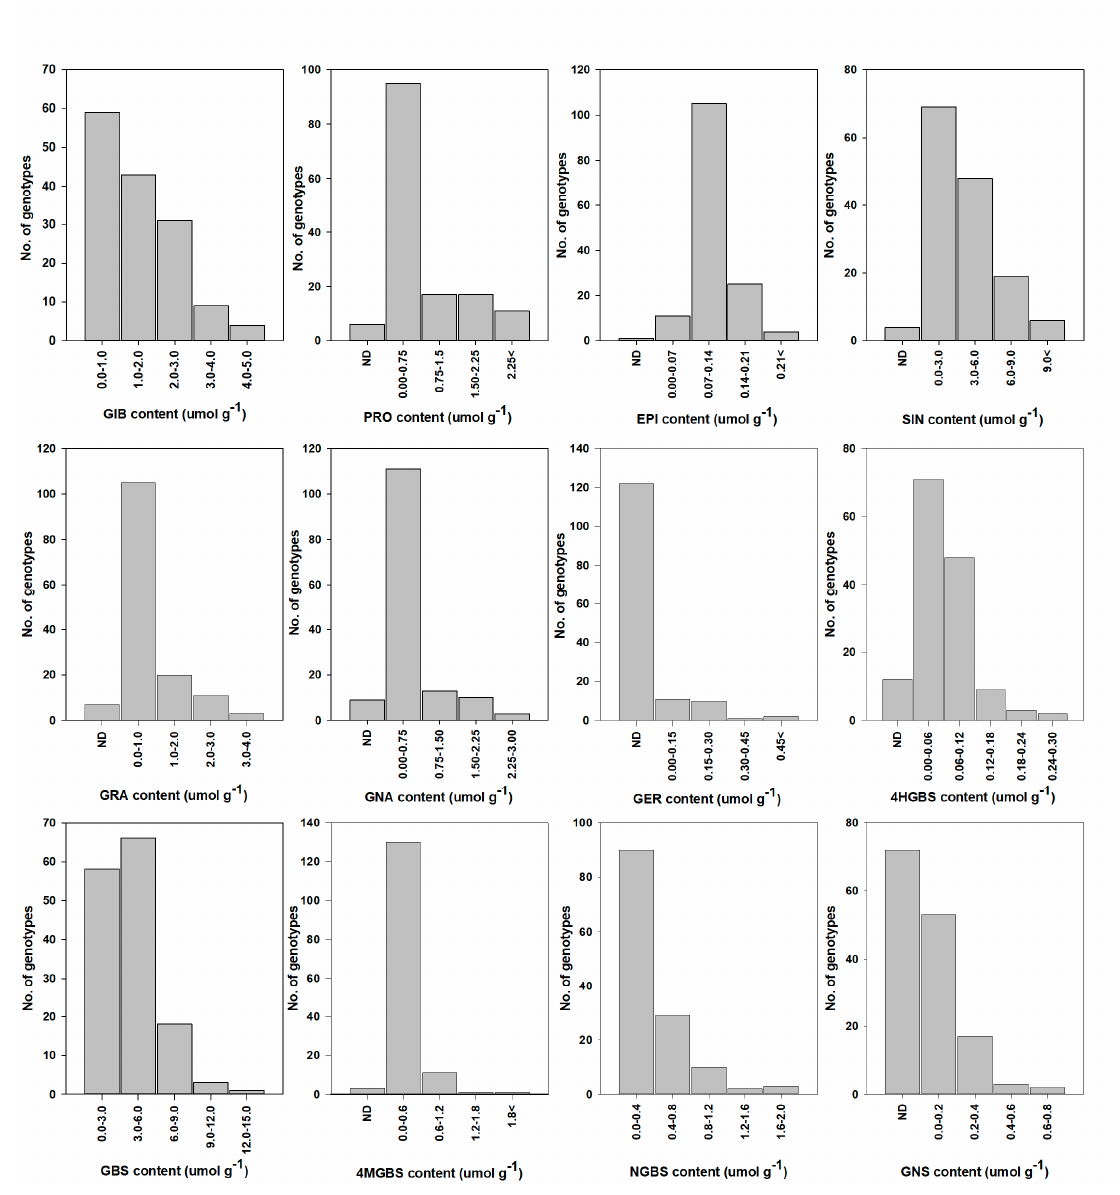
Figure 3 . Frequency of individual GSL distribution among the 146 cabbage genotypes. GIB: glucoiberin; PRO: progoitrin; EPI: epiprogoitrin; SIN: sinigrin; GRA: glucoraphanin; GNA: gluconapin; GER: glucoerucin; 4HGBS:4-hydroxyglucobrassicin; GBS: glucobrassicin; 4MGBS: 4- methoxyglucobrassicin; NGBS: neoglucobrassicin; GNS: gluconastrutiin; ND: not